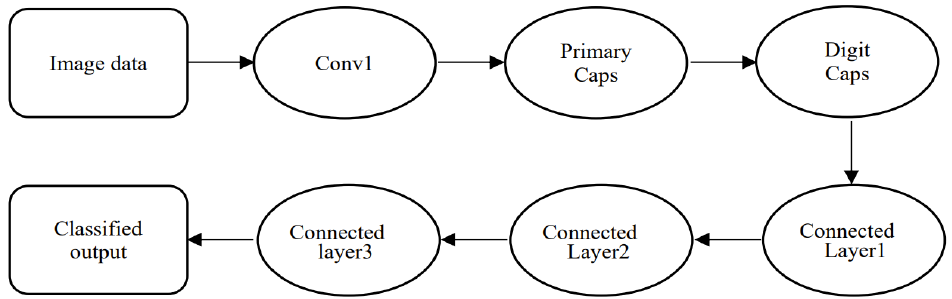
Figure 5. The structure diagram of the capsule network.